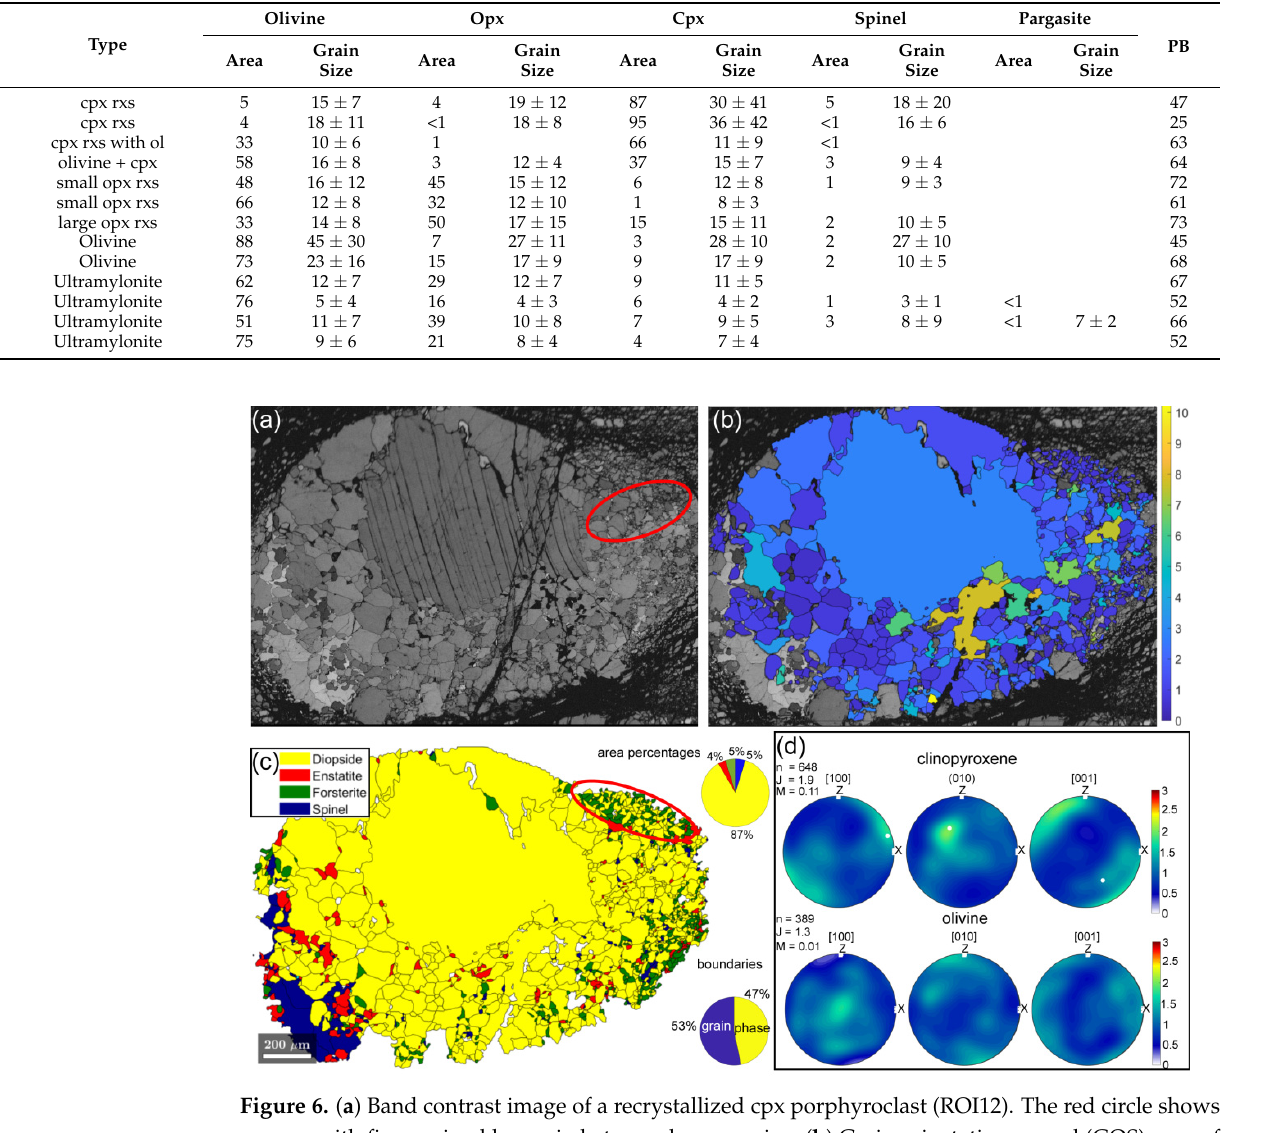
Table 1. Area percentages and grain sizes (µm), with the standard deviation, of all analyzed phases. The last column shows the proportion of phase boundaries (PB) of the total boundary length as a percentage.